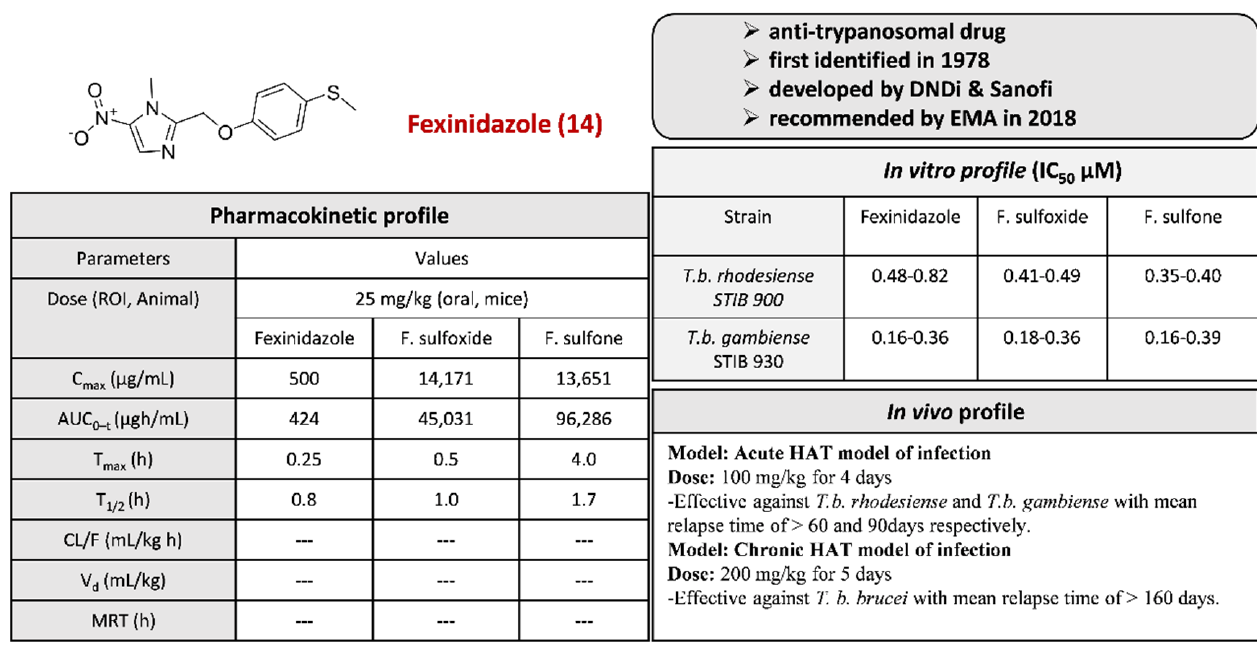
Scheme 36. Synthesis of Dimetridazole 13 . Reagents and conditions: ( A ) Dimethyl sulfate, HCOOH, 4 h, 87%; ( B ) MeI, Cs 2 CO 3 , DMF (yield not reported); ( C ) dimethyl sulfate, H 2 SO 4 , MeOH, 95 °C, 5 min, 97%.